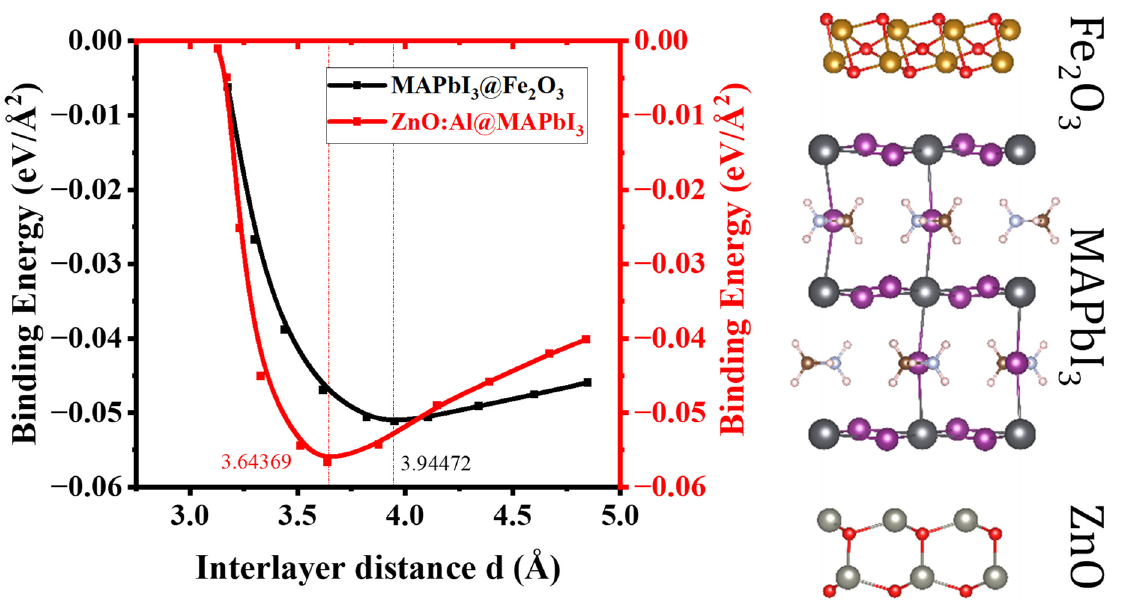
Figure 2. Variation in the interlayer binding energies, calculated using vdW-optB86b, with interlayer distance d (Å), in ZnO:Al/MAPbI 3 (3.64369 Å), and MAPbI 3 /Fe 2 O 3 (3.94472 Å) heterostructures. As can be seen in Figure 2, the binding energies of ZnO: Al/MAPbI (cid:2871) and MAPbI /Fe O − 0.05665 and − 0.05116 eV/Å, respectively, at the (cid:2871) (cid:2870) (cid:2871) heterostructures are vdW minima of ZnO: Al/MAPbI (cid:2871) (3.64369 Å) and MAPbI (cid:2871) /Fe (cid:2870) O (cid:2871) (3.94472 Å), suggesting